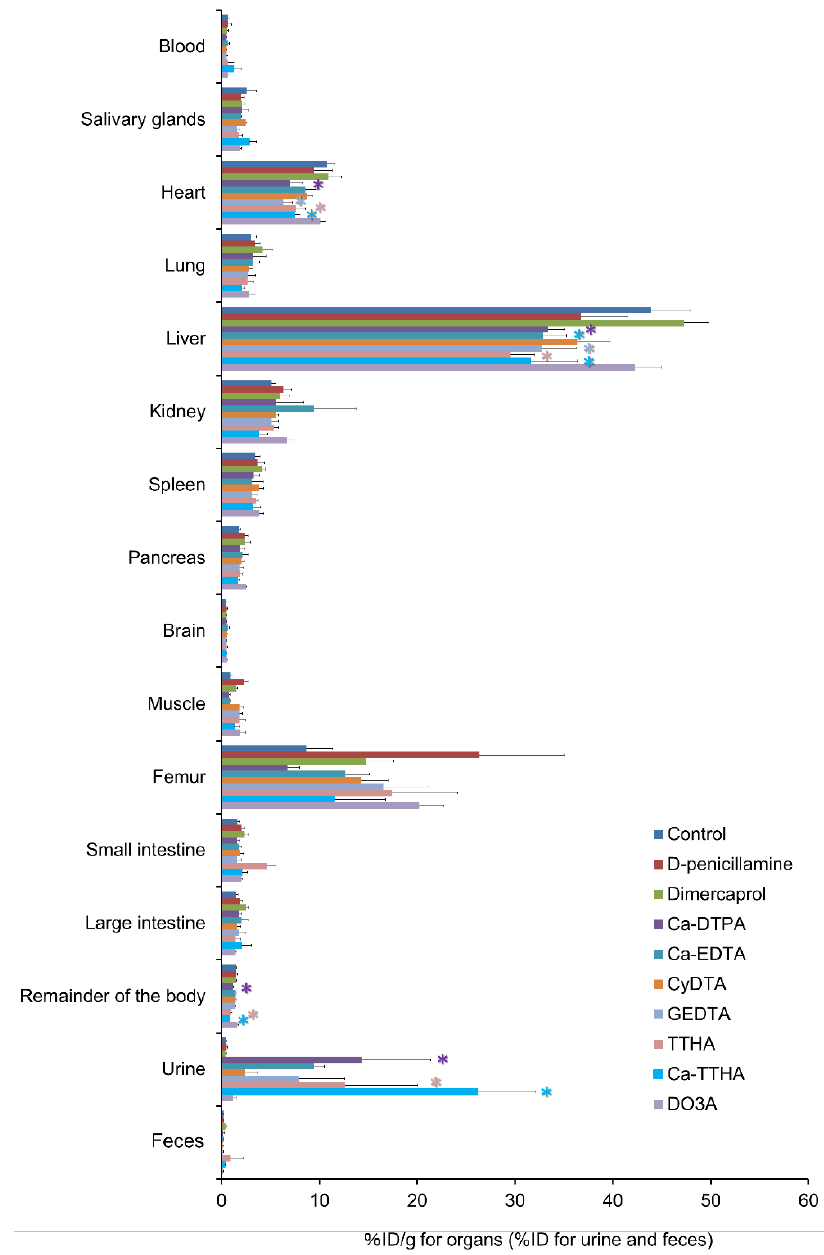
Figure 5. The effect of chelator administration on the biodistribution of free actinium-225 ( 225 Ac). * indicates statistical significance ( p < 0.05, vs. control).